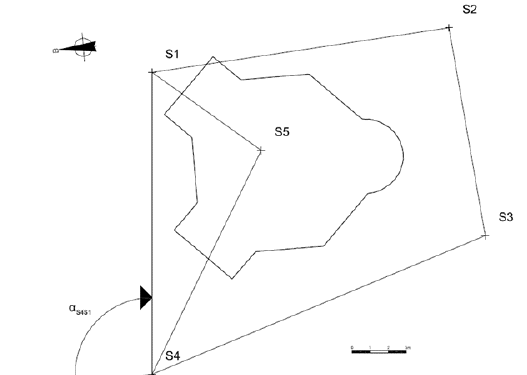
Figure 7: The traverse stations in relation with the